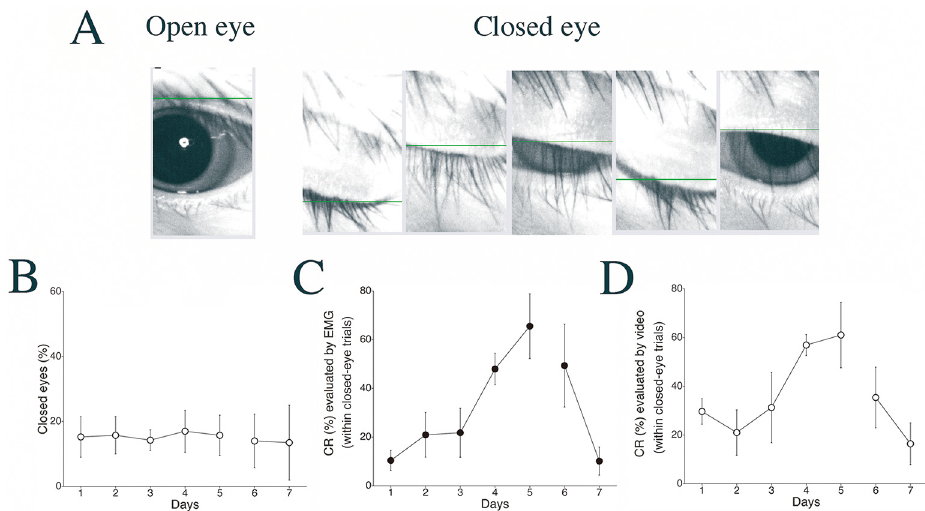
Fig 8. Changes in CR expression in cases of closed eyes. (A) Representative images of an “ open eye ” and a “ closed eye ” as judged by the video-tracking system. (B) The percentage of all trials that were “ closed- eye trials ” during delay eyeblink conditioning in monkeys. (C, D) The CR incidence (CR%) in the “ closed-eye trials ” as detected by EMG analysis (C) and as detected by the Intelligent Vision Sensor (D). Data are presented as mean ± S.E.M.